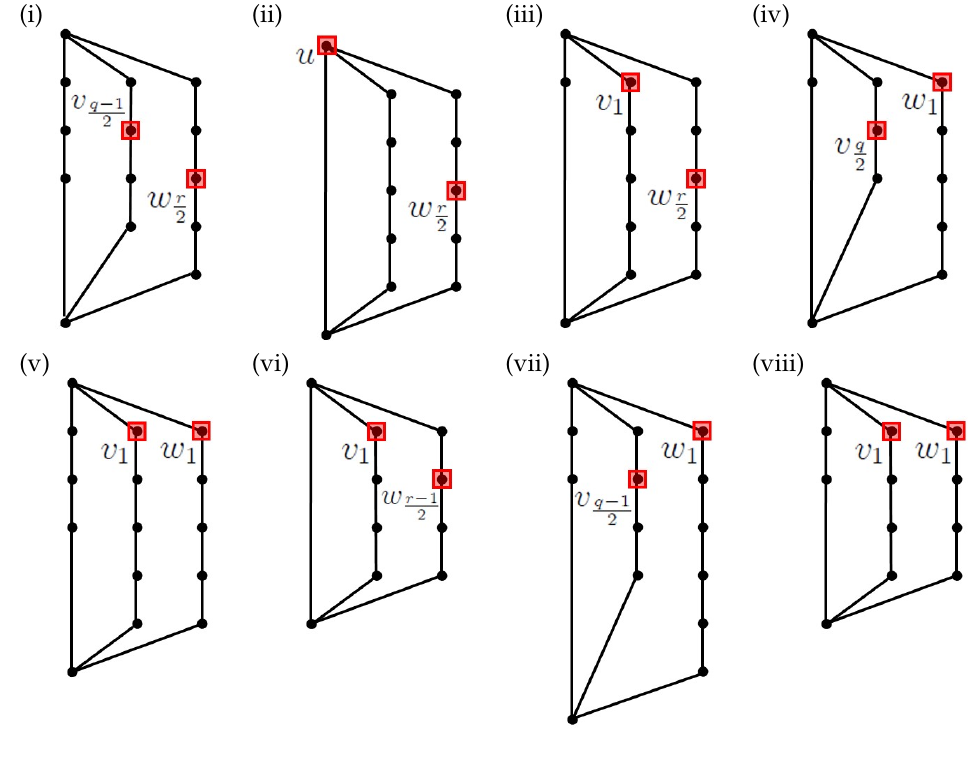
Figure 2. Vertex metric generators from Lemma